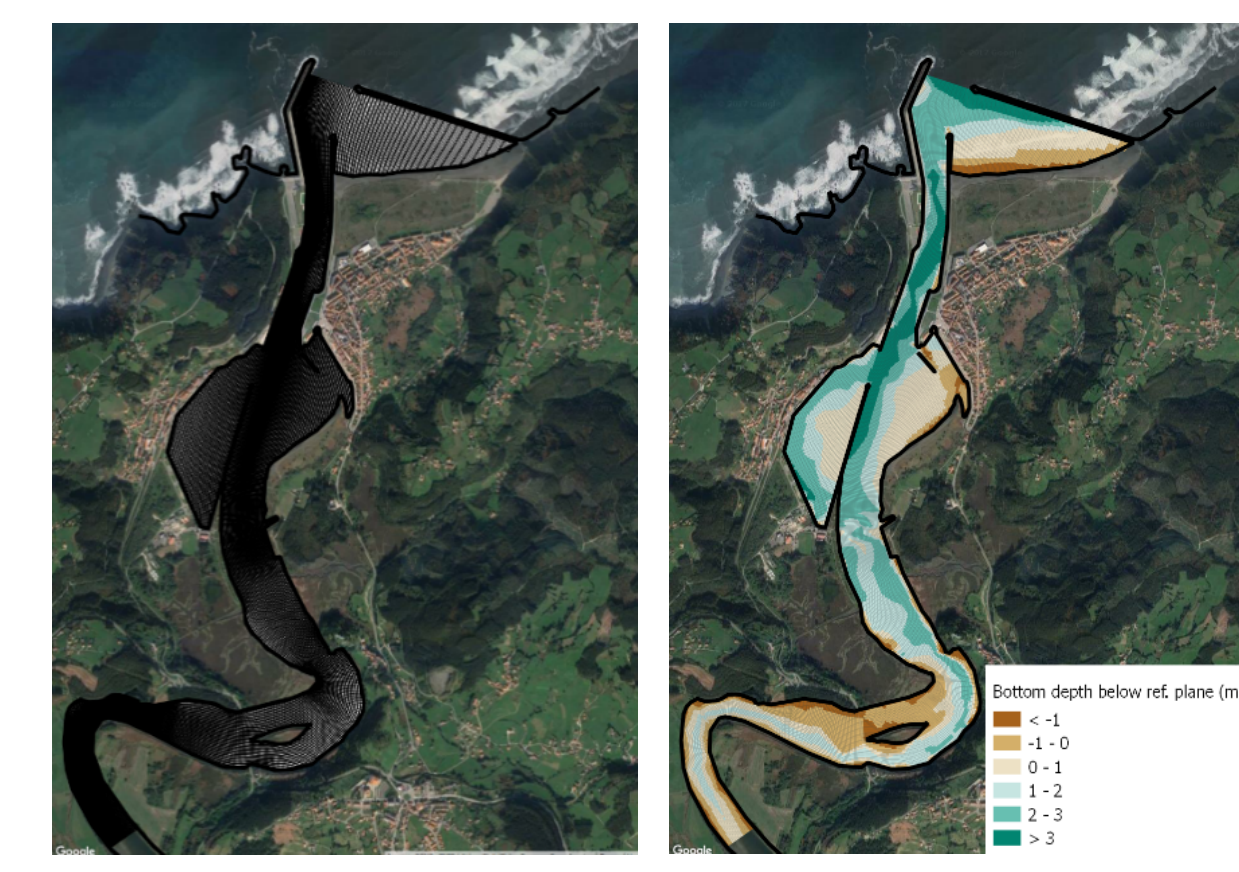
Figure 1: Computational mesh. Figure 2: Bottom depth below ref. plane (m).